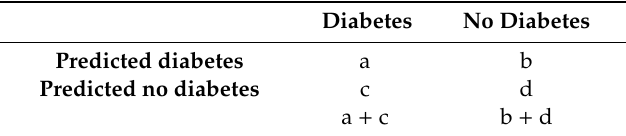
Table 8. General shape of the confusion matrix. Diabetes No Diabetes Predicted diabetes a b Predicted no diabetes c d a + c b + d